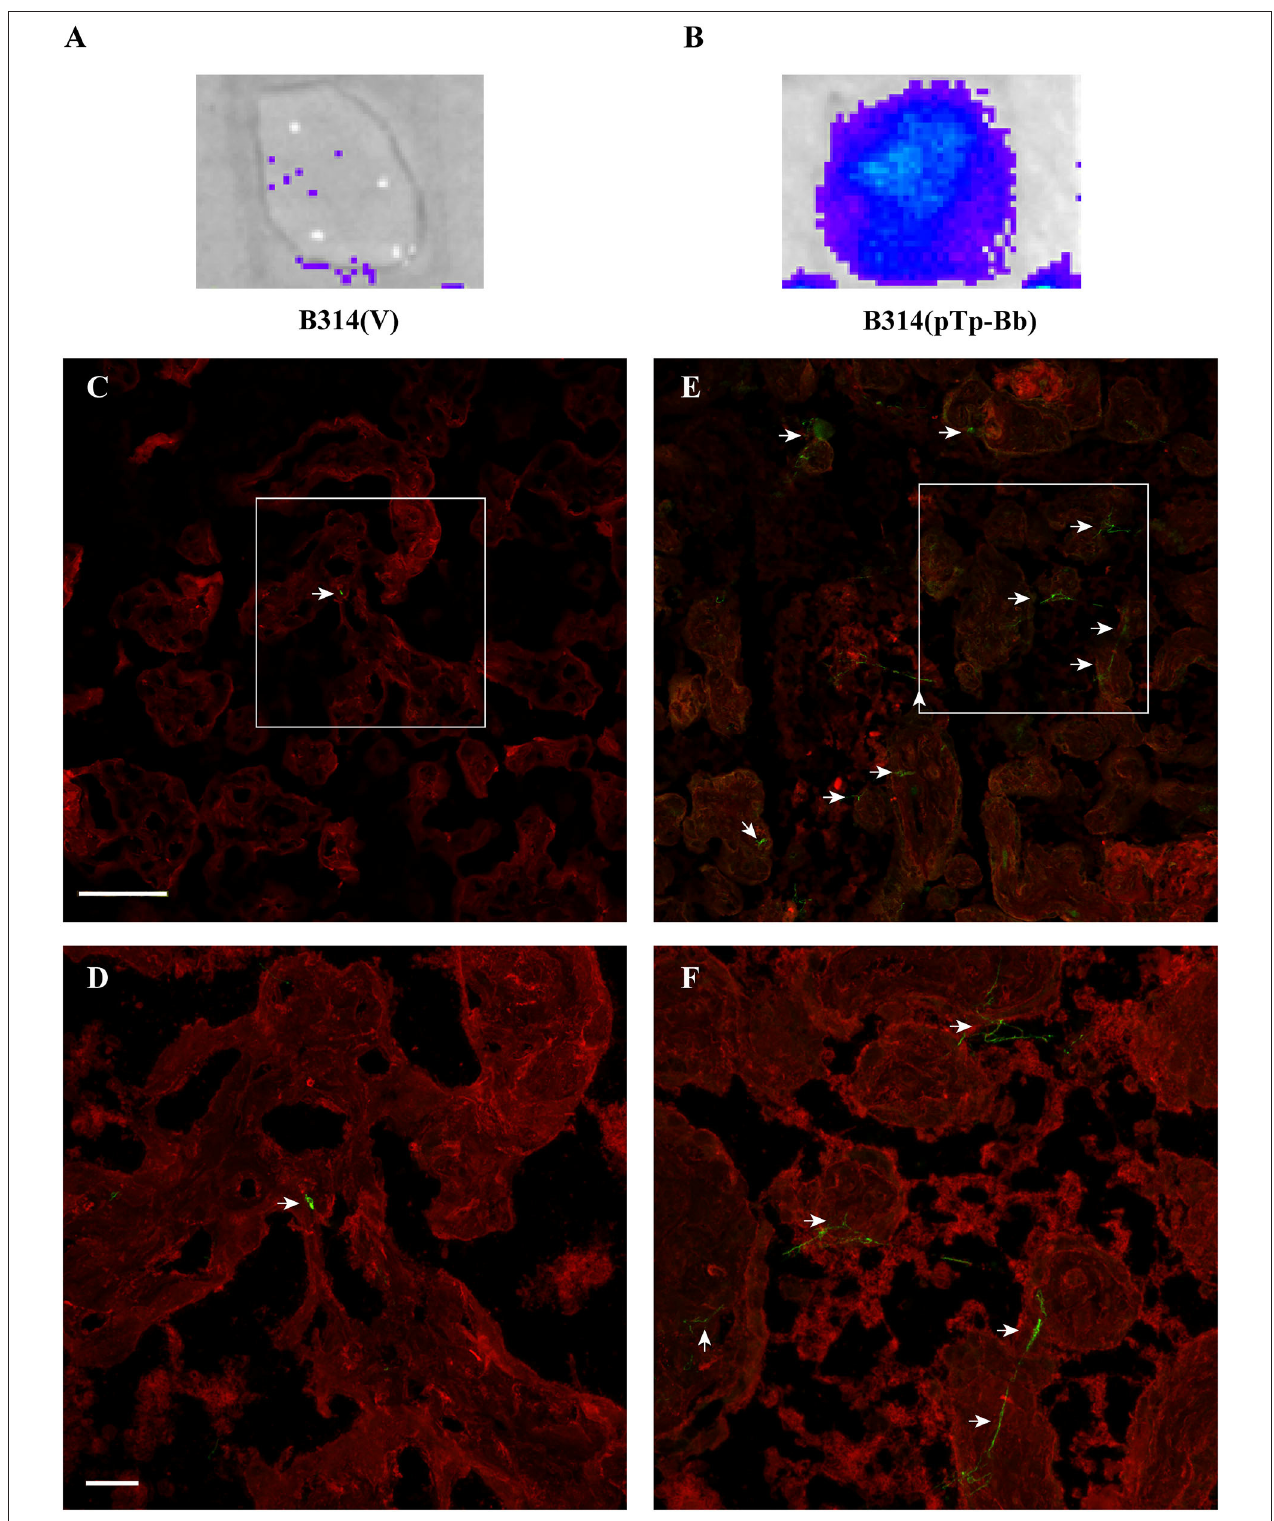
FIGURE 5 | B314 gains ability to bind to human placental tissue sections after Tp0954 expression. (A,B) B314(pTp-Bb) strain that expressed Tp0954 on the spirochete surface efficiently binds to placental tissue sections as detected by bioluminescence measurement by IVIS-50 after addition of D-luciferin substrate